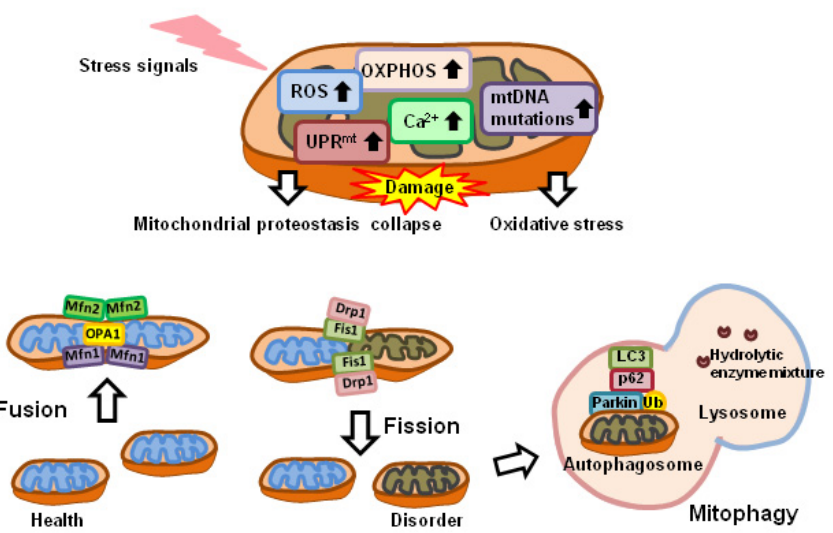
Figure 2. Mitochondrial dysfunction, dynamics, and mitophagy. Mitochondrial dysfunction is accompanied by increased ROS production, UPR mt , Ca 2+ , and mtDNA mutations, as well as altered cellular respiration and altered metabolism. Mitochondrial fission is the splitting of mitochondria into two smaller mitochondria. DRP1 is recruited by FIS1 anchored on the outer mitochondrial membrane. Mitochondrial fusion refers to the merging of two mitochondria into one. MFN1 and MFN2 mediate mitochondrial outer membrane fusion, and OPA1 mediates mitochondrial inner membrane fusion. After mitochondrial depolarization, PINK1 accumulates on the outer mitochondrial membrane (OMM) and recruits Parkin to the mitochondrial surface. Parkin ubiquitinates various OMM proteins. Polyubiquitinated proteins can be recognized by adaptor molecules, such